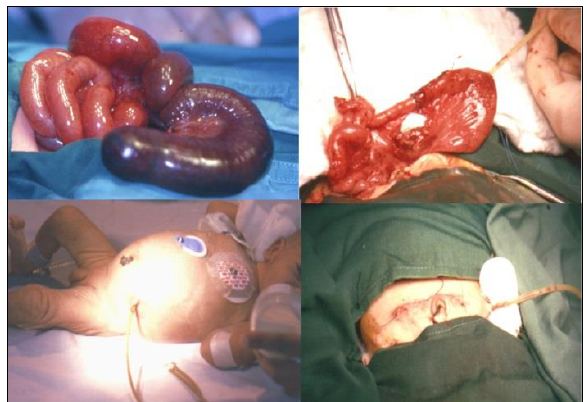
Figure 1: T-tube enterostomy technique in cases of jejunoileal